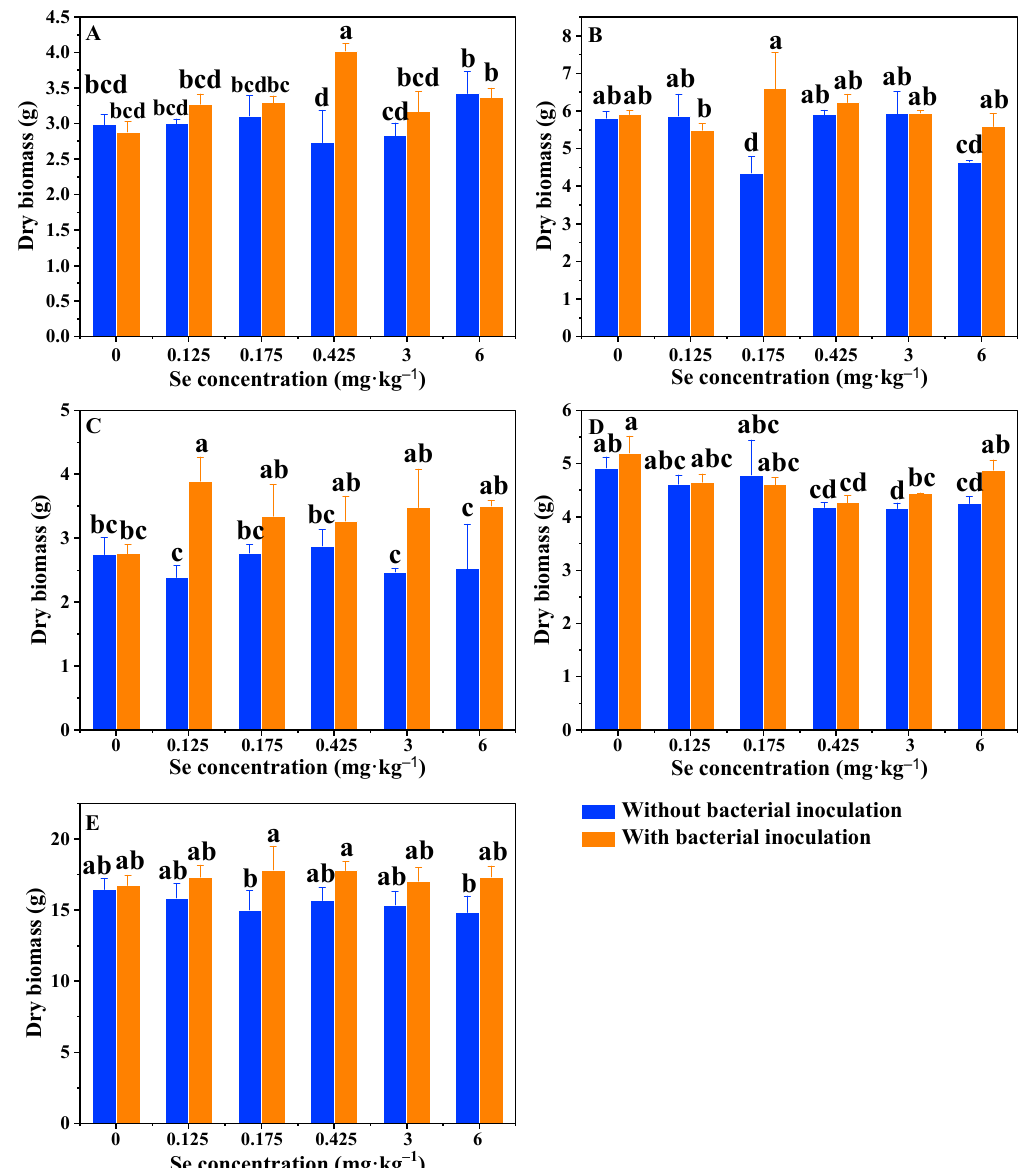
Figure 4. Dry weight of the root biomass ( A ), husk biomass ( B ), leaf biomass ( C ), grain biomass ( D ) and total biomass ( E ) of rice plant with or without the inoculation of strain LWS1 ( n = 4). The plants were grown in soils spiked with 0–6 mg·kg –1 SeIV. Different letters indicate signi fi cant differences between treatments based on two-way ANOVA by Tukey's multiple comparisons test at p ≤ 0.05.